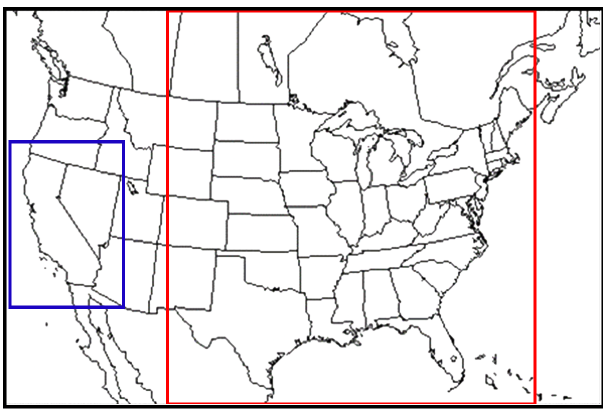
Figure 2. Regional representation of the CA (blue box), EUS (red box) and CONUS